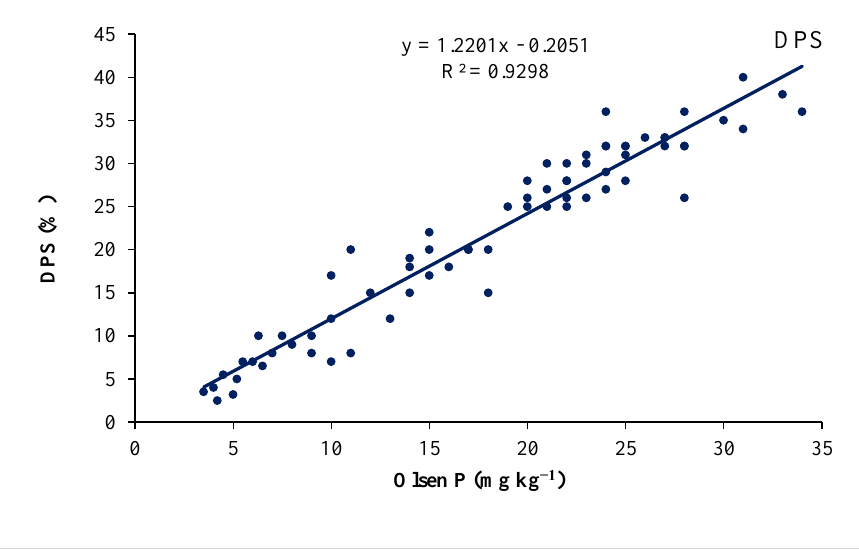
Figure 1. The liner regression correlation between available P and DPS. The number of samples is 144. Table 3. The effect of P doses on mango growth. Means ( ± SE, n = 16) denoted by different letters indicate significant difference according to Duncan’s test at p < 0.05. p is p value of the ANOVA